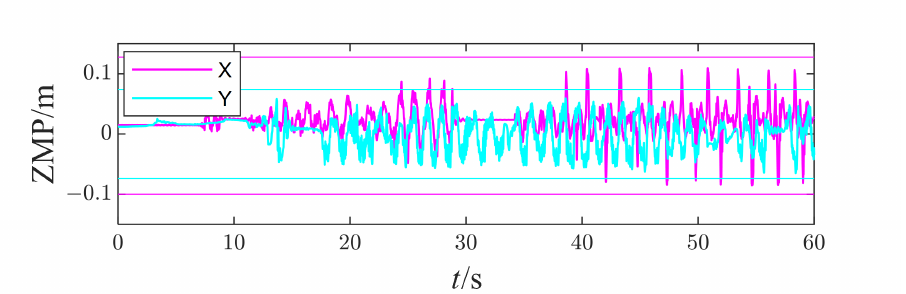
Figure 11. The measured ZMP of the right